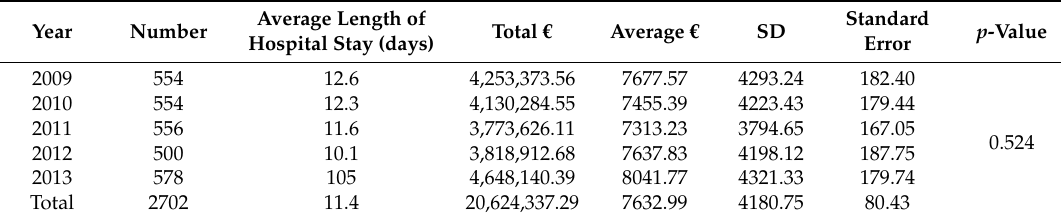
Table 1. Total annual treatment cost in public hospitals in Valencia.